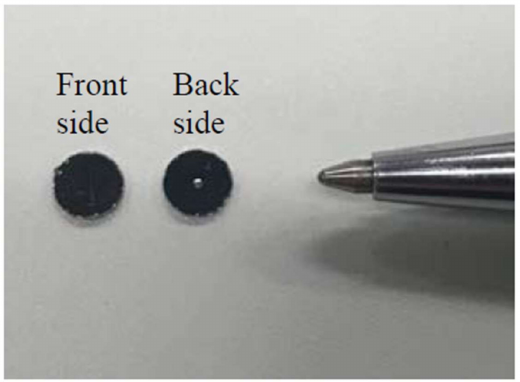
Figure 5. Disk-shaped resonator fabricated by photolithography ( d = 4 mm, d c = 0.5 mm, h = 0.5 mm, h c = 0.1